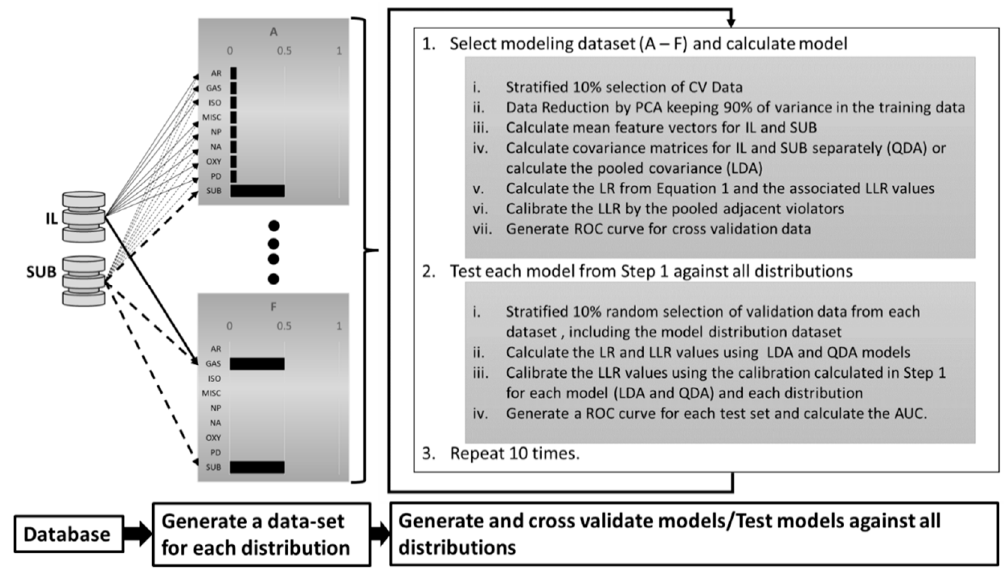
Figure 1. Diagram showing the model construction and testing steps.